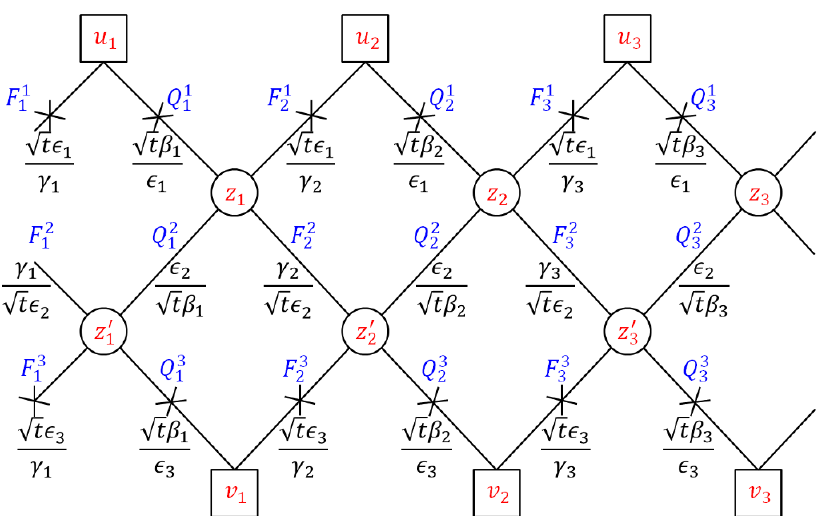
Figure 21 . The trinion with three maximal punctures. Here depicted in the case of k = 3 where the two edges of the quiver are identi(cid:12)ed as this is a circular quiver. The k U(1) (cid:15)